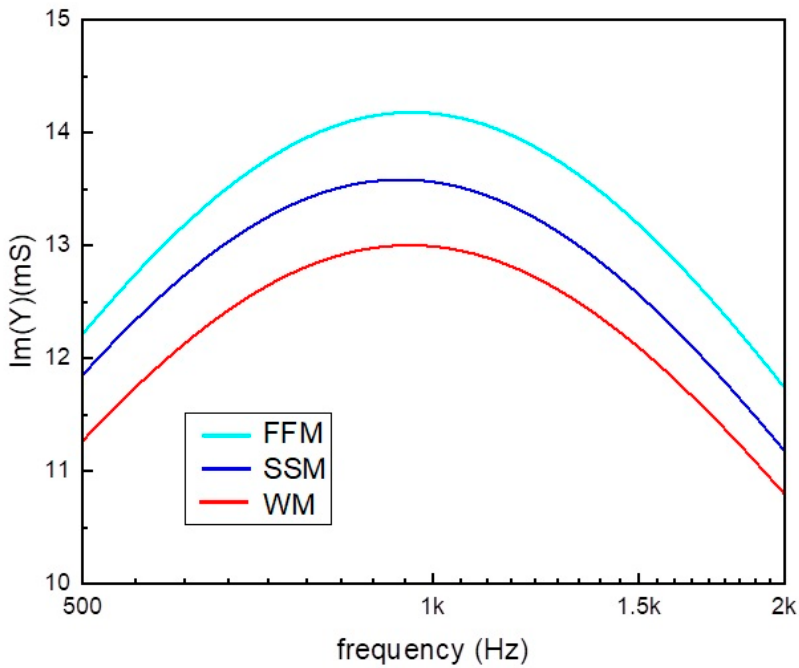
Figure 4. ( a ) Imaginary part of the admittances of different types (whole, semi-skimmed, fat and lactose-free, lactose-free) of milk from the same brand; ( b ) Detail of Figure 3a. In Figure 5, a comparison is reported between the fat-free (but with lactose) milk and the semi-skimmed and whole milk from the same brand, but different from the brand in Figure 4.